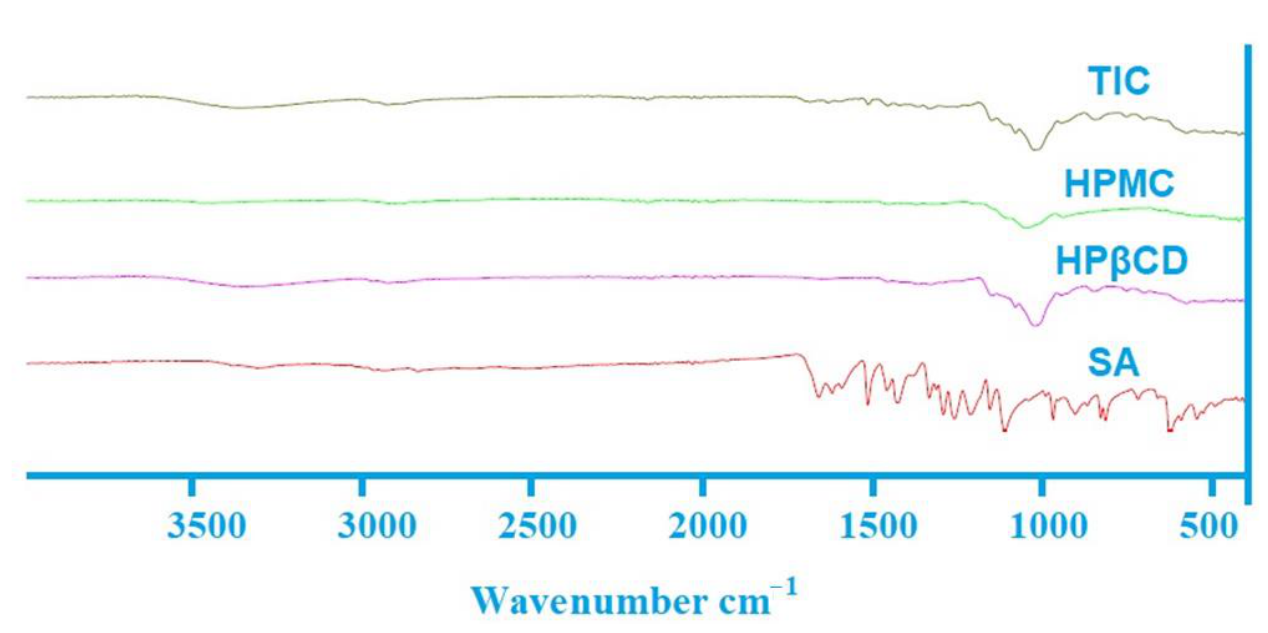
Figure 4. FTIR spectra of SA, HPβCD, HPMC and TIC.